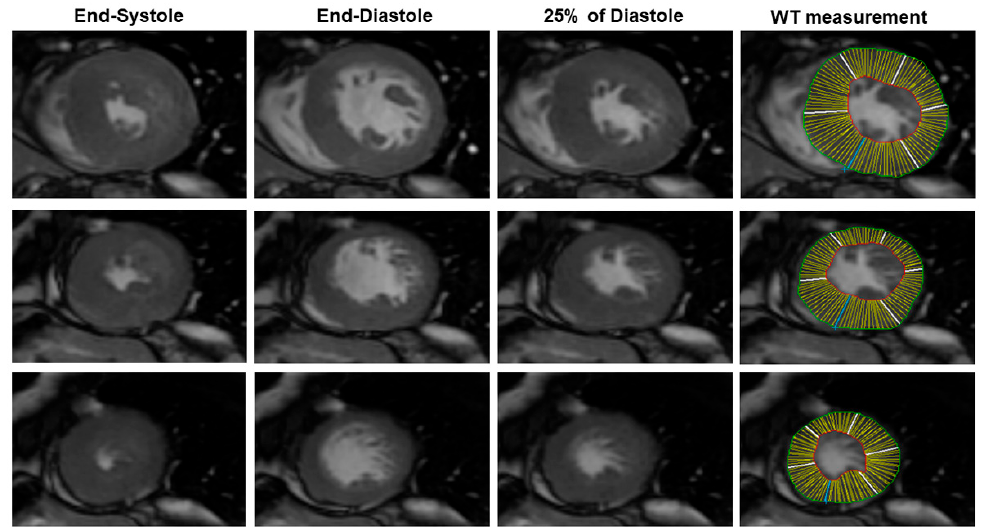
Figure 1. Example of in vivo analysis of cine SSFP images. The cardiac phase corresponding to 25% of the diastole was chosen to simulate rigor mortis. Endocardial and epicardial contours were manually traced excluding papillary muscles. The average myocardial wall thickness (WT) was automatically measured in each of the 17 conventional myocardial segments. The left ventricular (LV) mass, the mean WT, the standard deviation (SD) of WT, the maximal WT, the minimal WT, and the maximal-minimal di ff erence of WT were